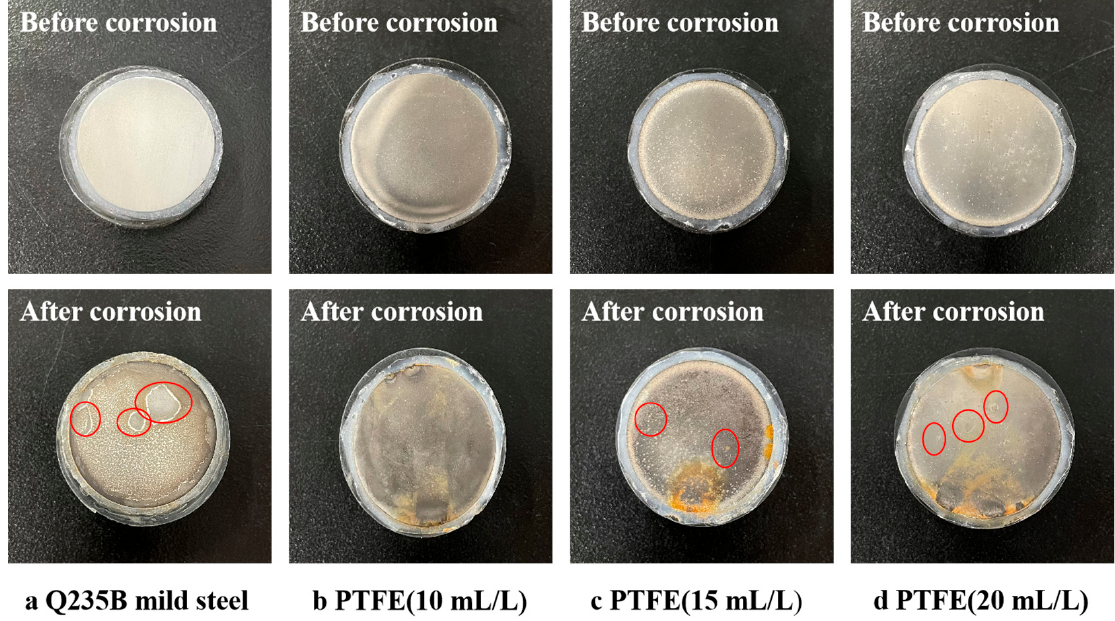
Figure 7. The surface macromorphology of Q235B mild steel and Ni-Cu-P-PTFE composite coatings with different PTFE concentrations before and after corrosion. The red circled ones represent corrosion pits.